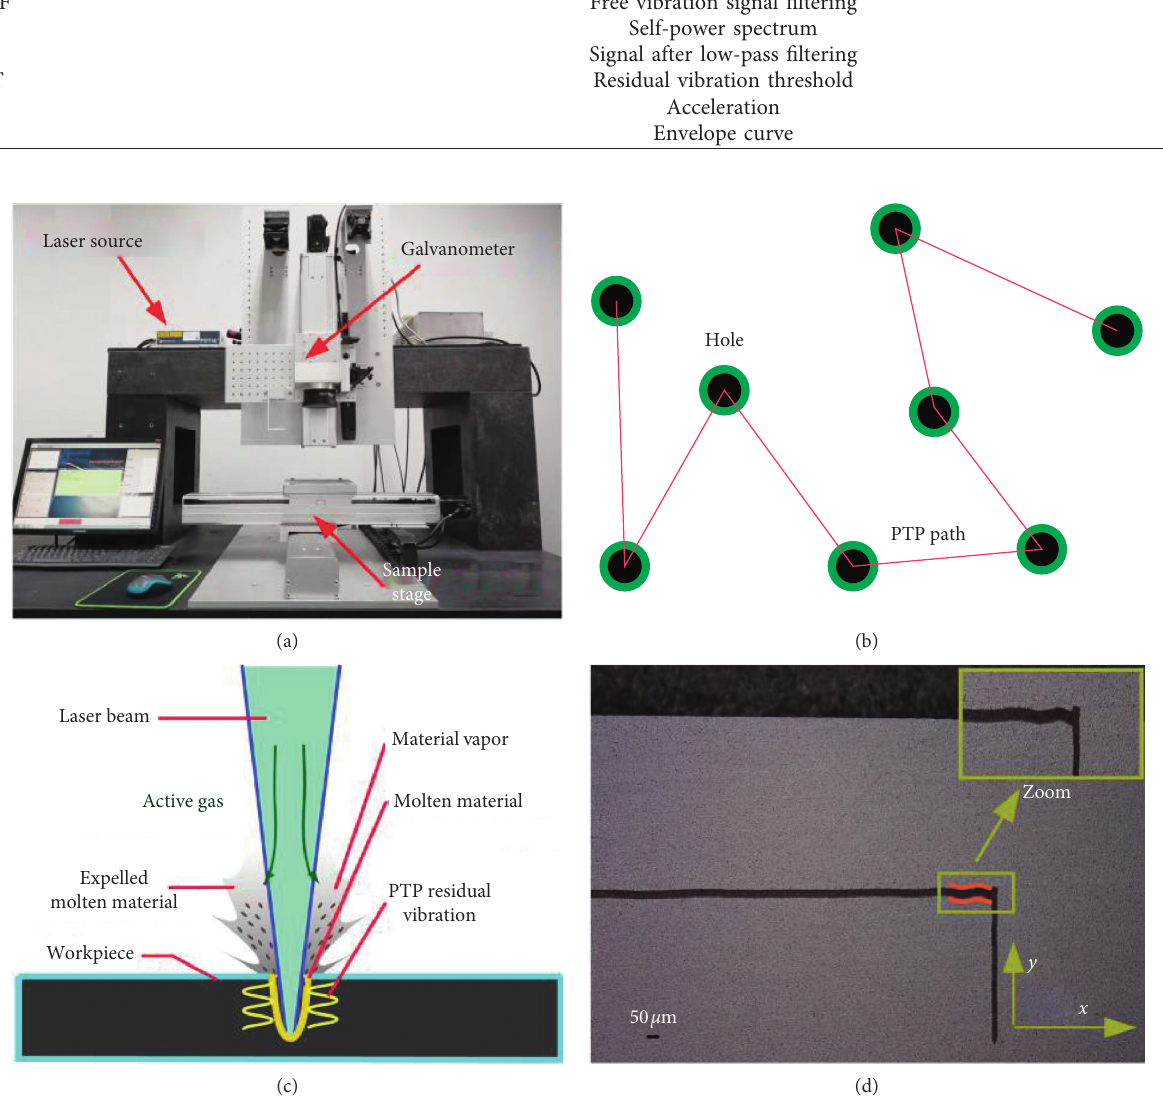
Figure 1: Schematic diagram of laser drilling. (a) Laser processing equipment; (b) PTP motion; (c) PTP residual vibration in laser drilling; (d) Residual vibration at the corner of the machining